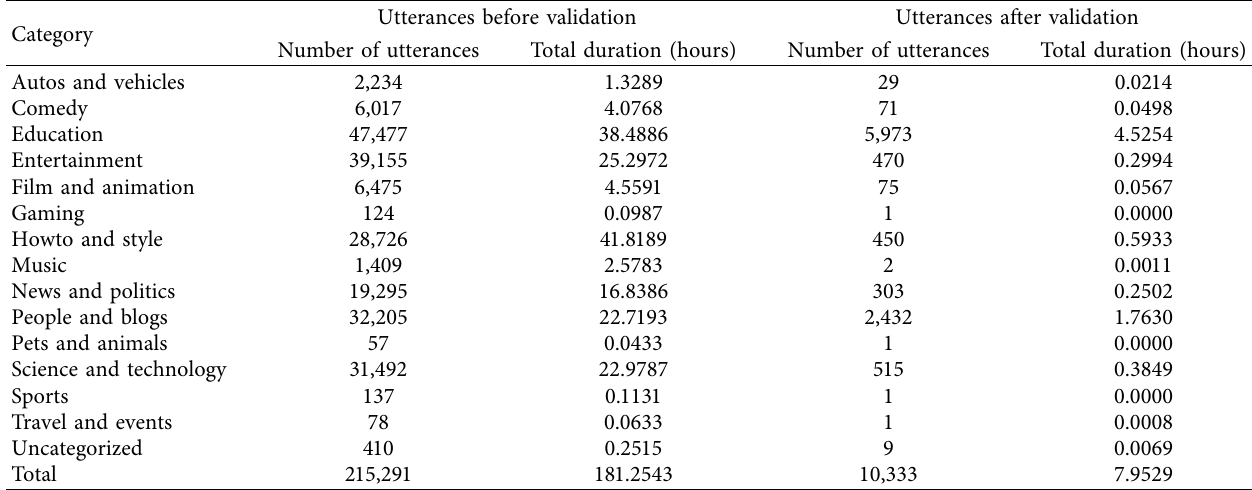
Table 4: The dataset of Indonesian audio after first validation (approx. size 10,000